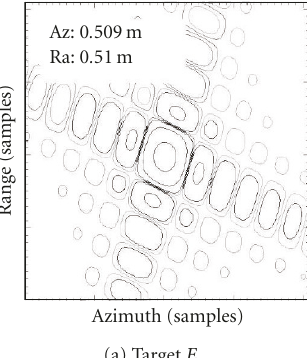
Figure 3: Geometry of the illuminated scene.